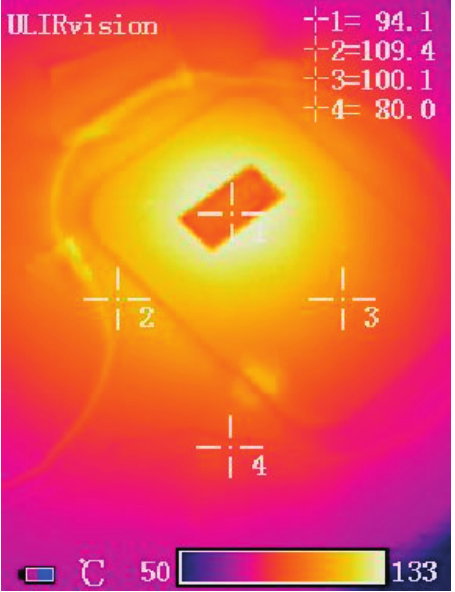
Figure 6. Image captured during the heating of the sensor using Infrared